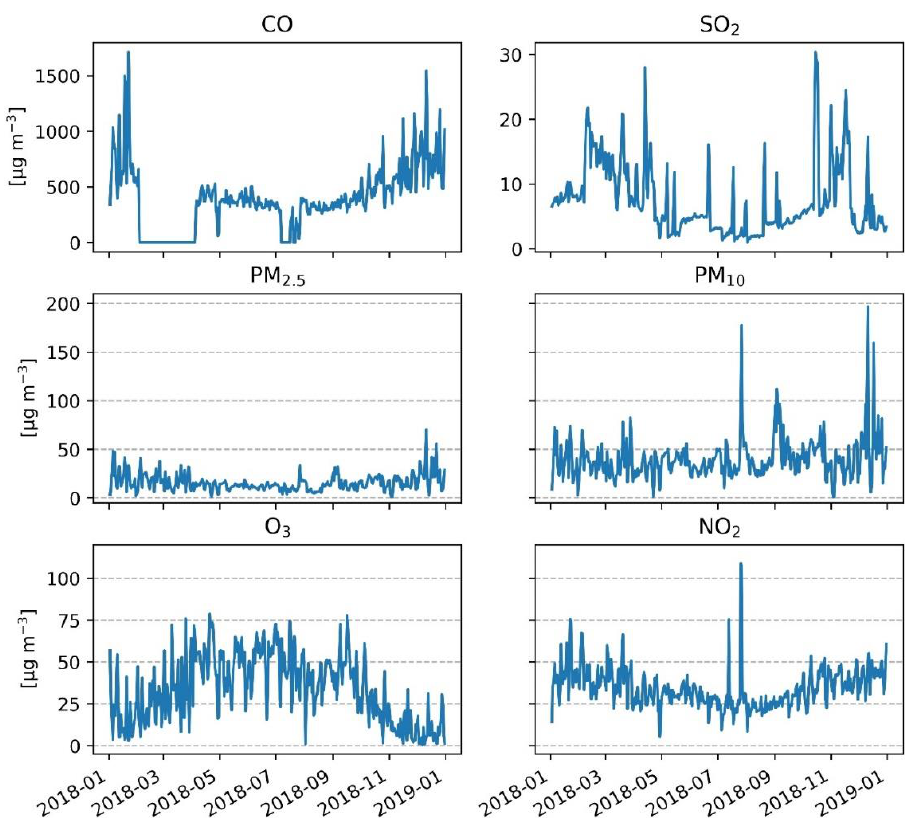
Figure 3. Daily average pollution concentration of CO, SO 2 , PM 2.5 , PM 10 , O 3 , and NO 2 in Tbilisi (year: 2018).